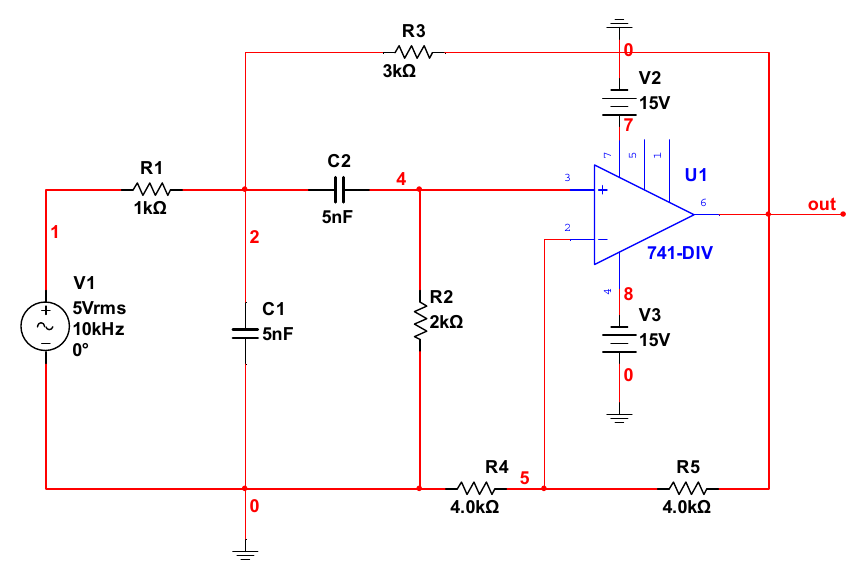
Figure 15. Sallen–Key bandpass filter circuit.